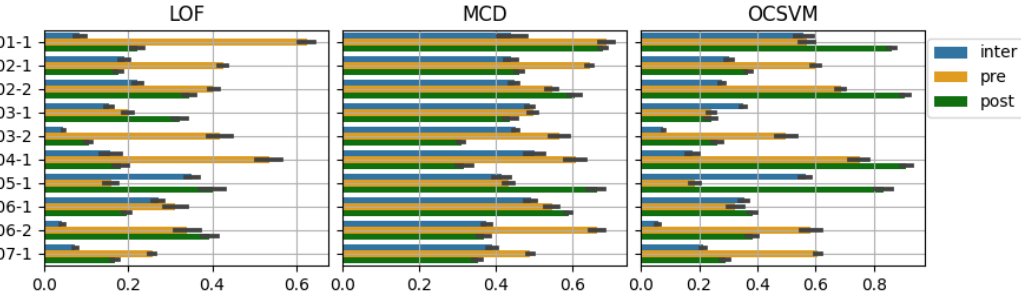
Figure 5. Bar plot of min-max scaled mean score values per detector for different patient states; deviation is depicted with gray bars. Table 6. Min-max scaled average score (± standard deviation) at different ictal states per model . 1